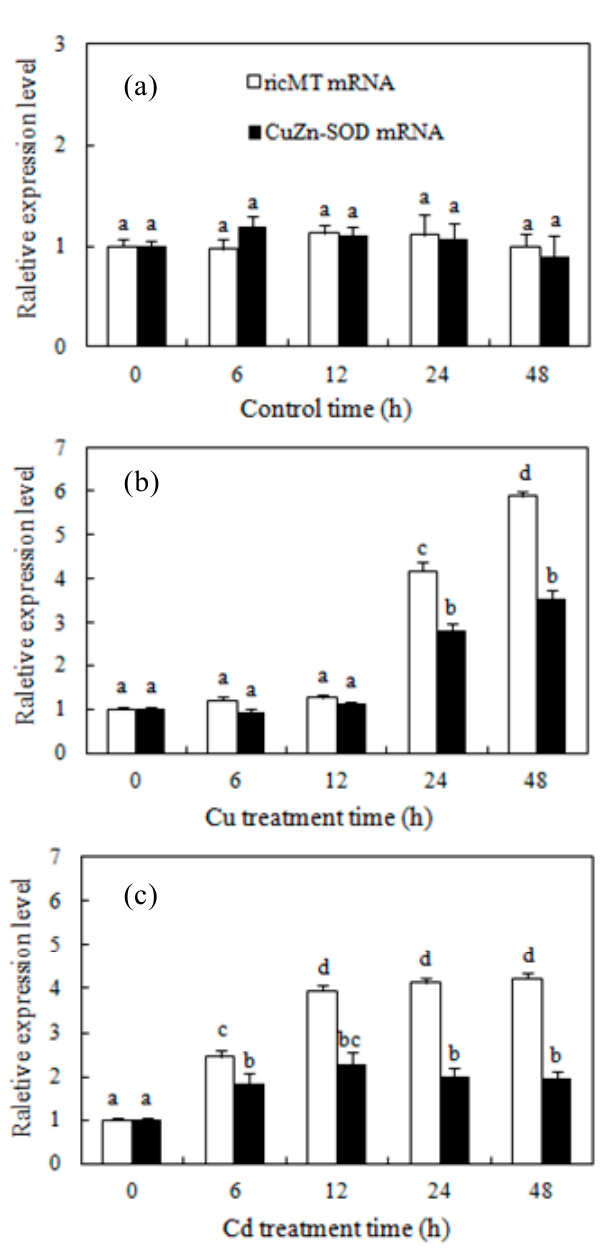
Figure 2. Time course for Cu- and Cd-induced expression of ricMT and CuZn-SOD . ( a – c ) Time course for control ( a ); Cu-induced ( b ) and Cd-induced ( c ) expression of ricMT and CuZn-SOD . Germinating rice embryos were treated with distilled water (control), 100 µ M CuSO 4 or 100 µ M CdCl 2 for various times (0, 6, 12, 24, and 48 h). Subsequently, radicles were isolated from the germinating seeds for gene analyses by quantitative RT-PCR. Values are means ± SE ( n = 3) of three separate experiments. Means denoted by the same letter did not significantly differ at p < 0.05 according to Duncan’s multiple range test.